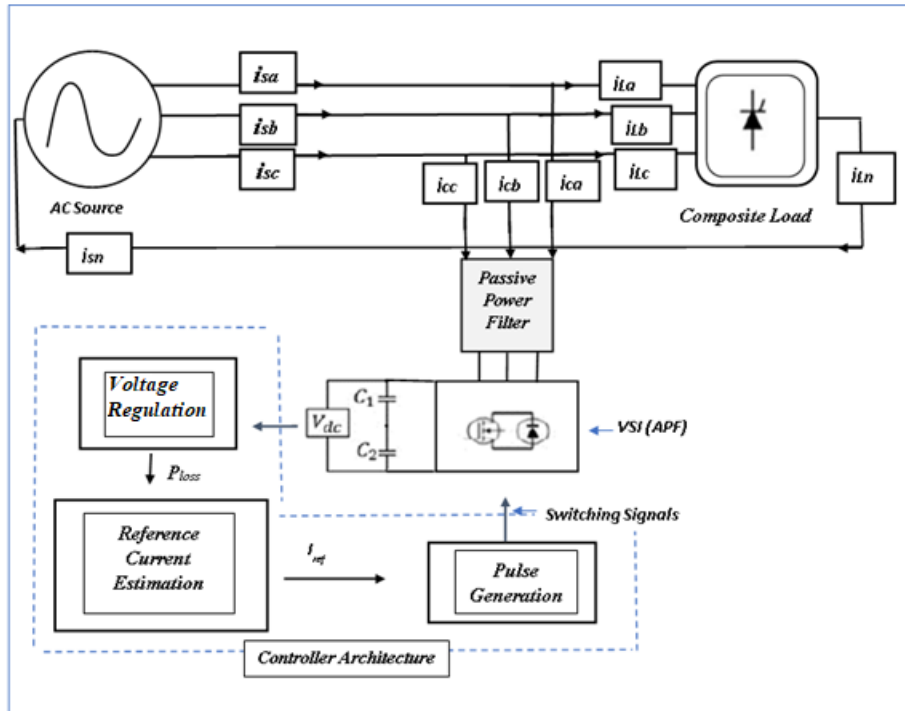
Figure 3. Hybrid filter scheme for nonlinear load.